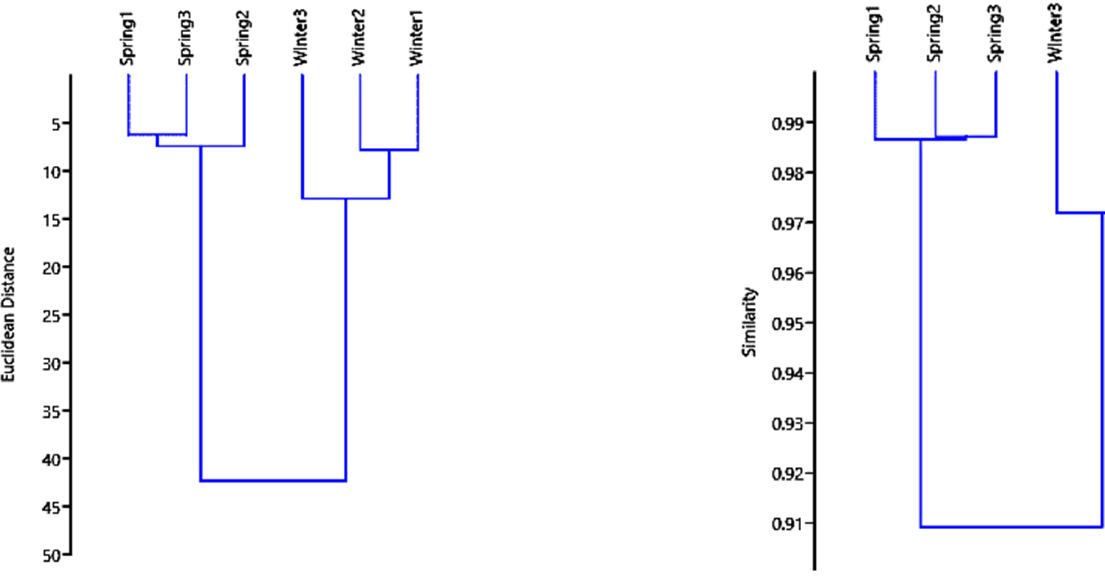
Figure 1. Hierarchical clustering of harvest seasons (spring vs. winter) using chemical composition and in vitro fermentation kinetic data of Paulownia shan tong.